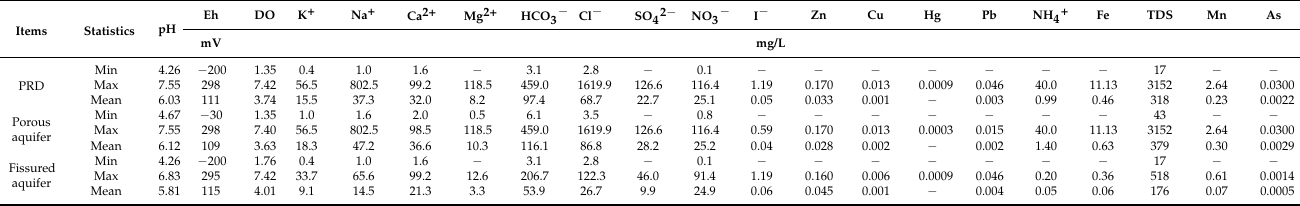
Table 3. Statistics of the concentrations of groundwater chemicals in agricultural lands in the Pearl River Delta.